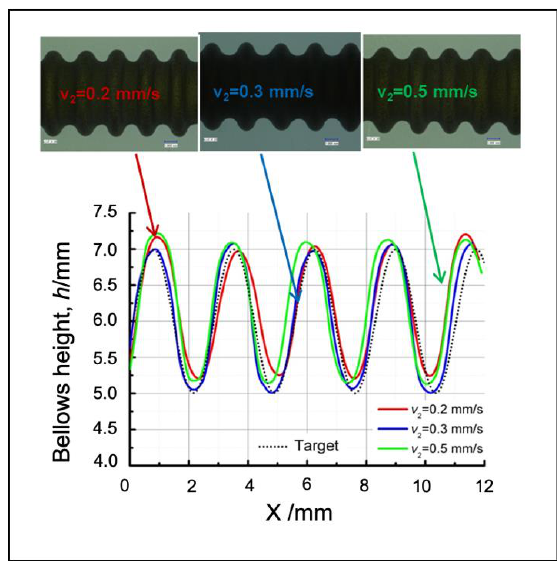
Figure 19. Bellows profile at various feeding speeds.